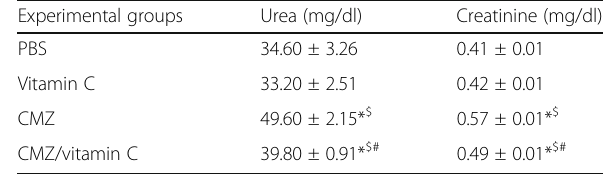
Table 3 Changes in the level of serum liver biochemical markers; transaminase activity (AST and ALT) and alkaline phosphatase activity (ALP) of male Swiss albino mice treated with PBS, vitamin C (1136 μ M/kg), CMZ (46 μ M/kg), or a combination of CMZ and vitamin C with the same dose of each intraperitoneally (i.p.) daily